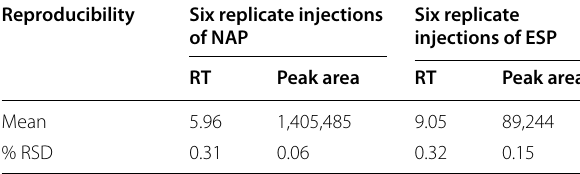
Table 7 Reproducibility of ESP and NAP